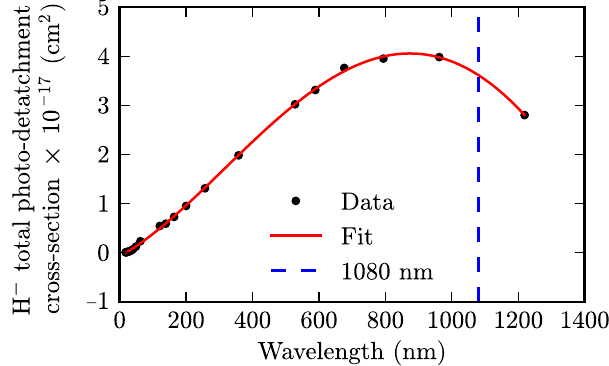
FIG. 2. Cross-section of the photo-detachment process of a nonrelativistic H − ion. The dashed line indicates the selected laser wavelength for the emittance measurements at 3